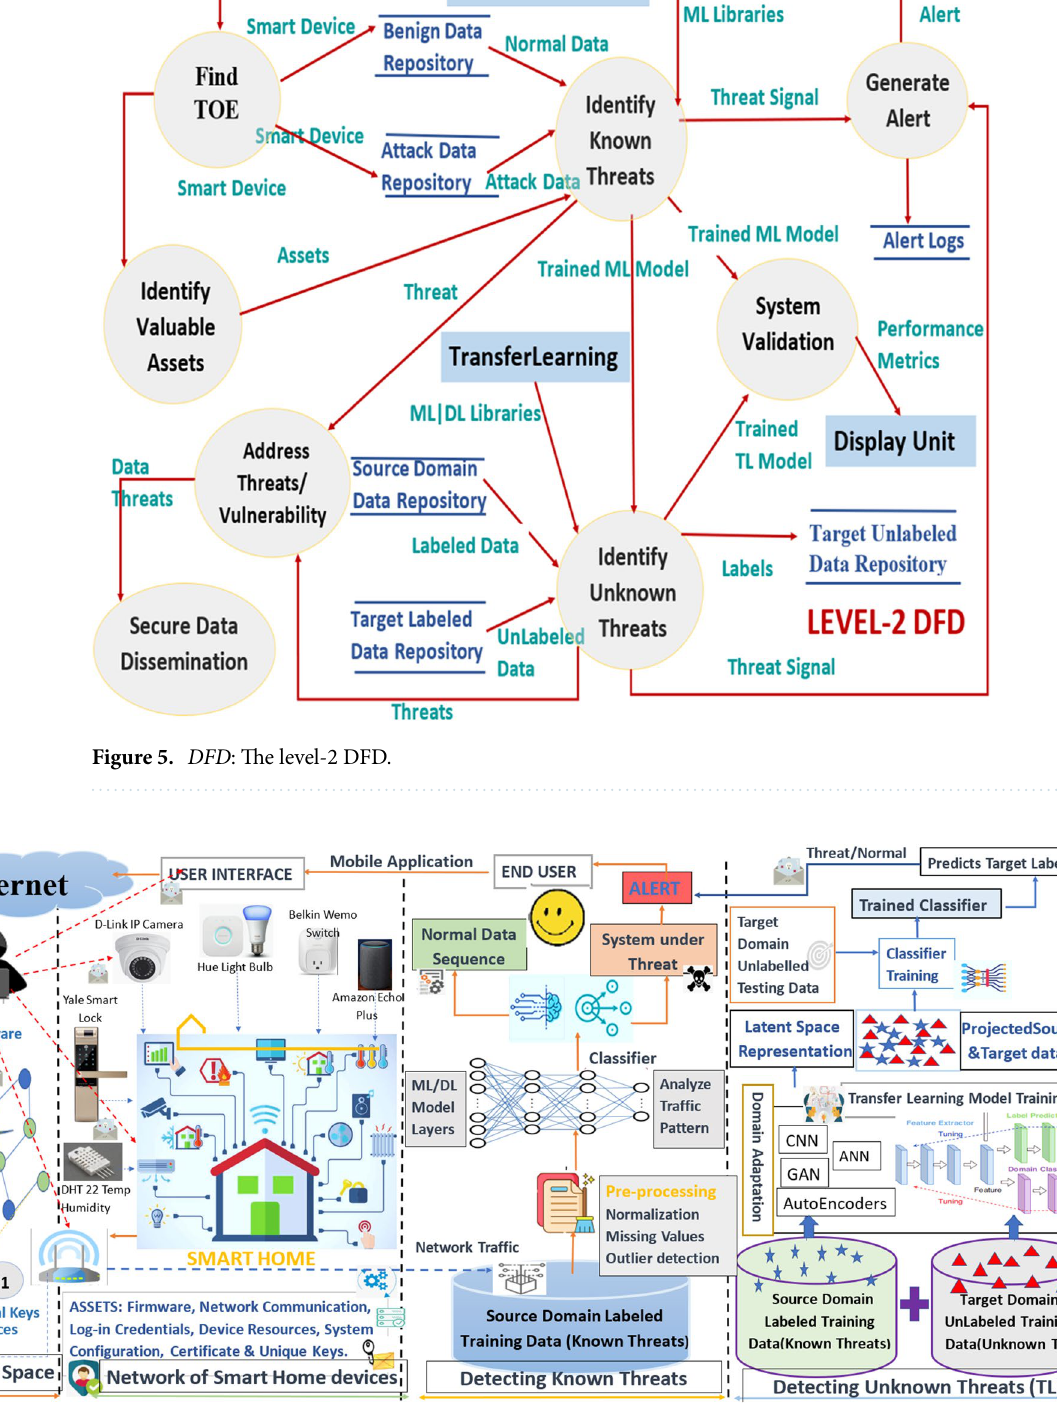
Figure 6. SALT : The Threat